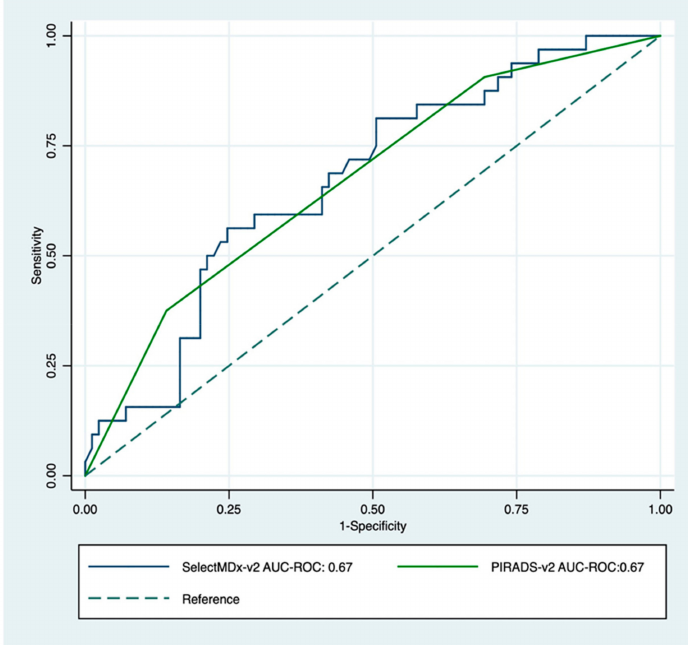
Figure 3. Receiver operating characteristic curve for PI-RADS-v2 score (green) and SelectMDx-v2; (blue) for the detection of high-grade cancer on image-guided biopsy. The dotted diagonal line is the reference line (AUC =